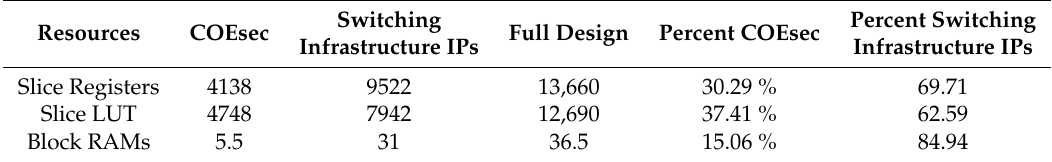
Table 2. COEsec comparison with switching infrastructure implemented on the